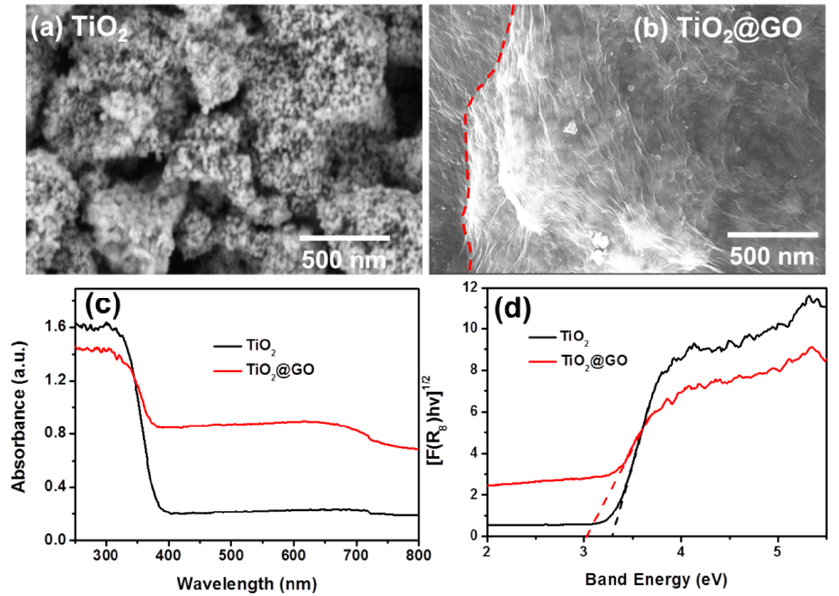
Figure 1. SEM of ( a ) TiO 2 and ( b ) TiO 2 @GO, ( c ) the UV-vis DRS, and ( d ) the plots of [ F(R ∞ )hv ] 1/2 vs. photon energy of TiO 2 and TiO 2 @GO.